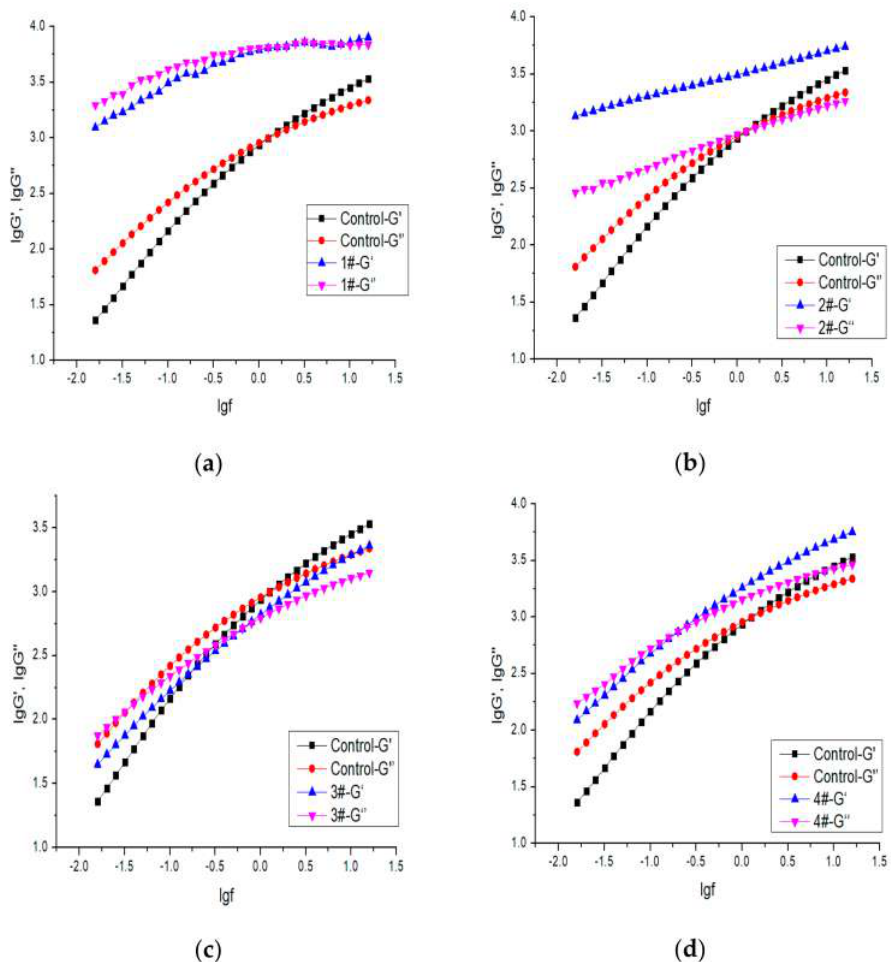
Figure 2. Comparison of dynamic-state rheological curves: ( a ) sample 1# vs. control sample; ( b ) sample 2# vs. control sample; ( c ) sample 3# vs. control sample; ( d ) sample 4# vs. control